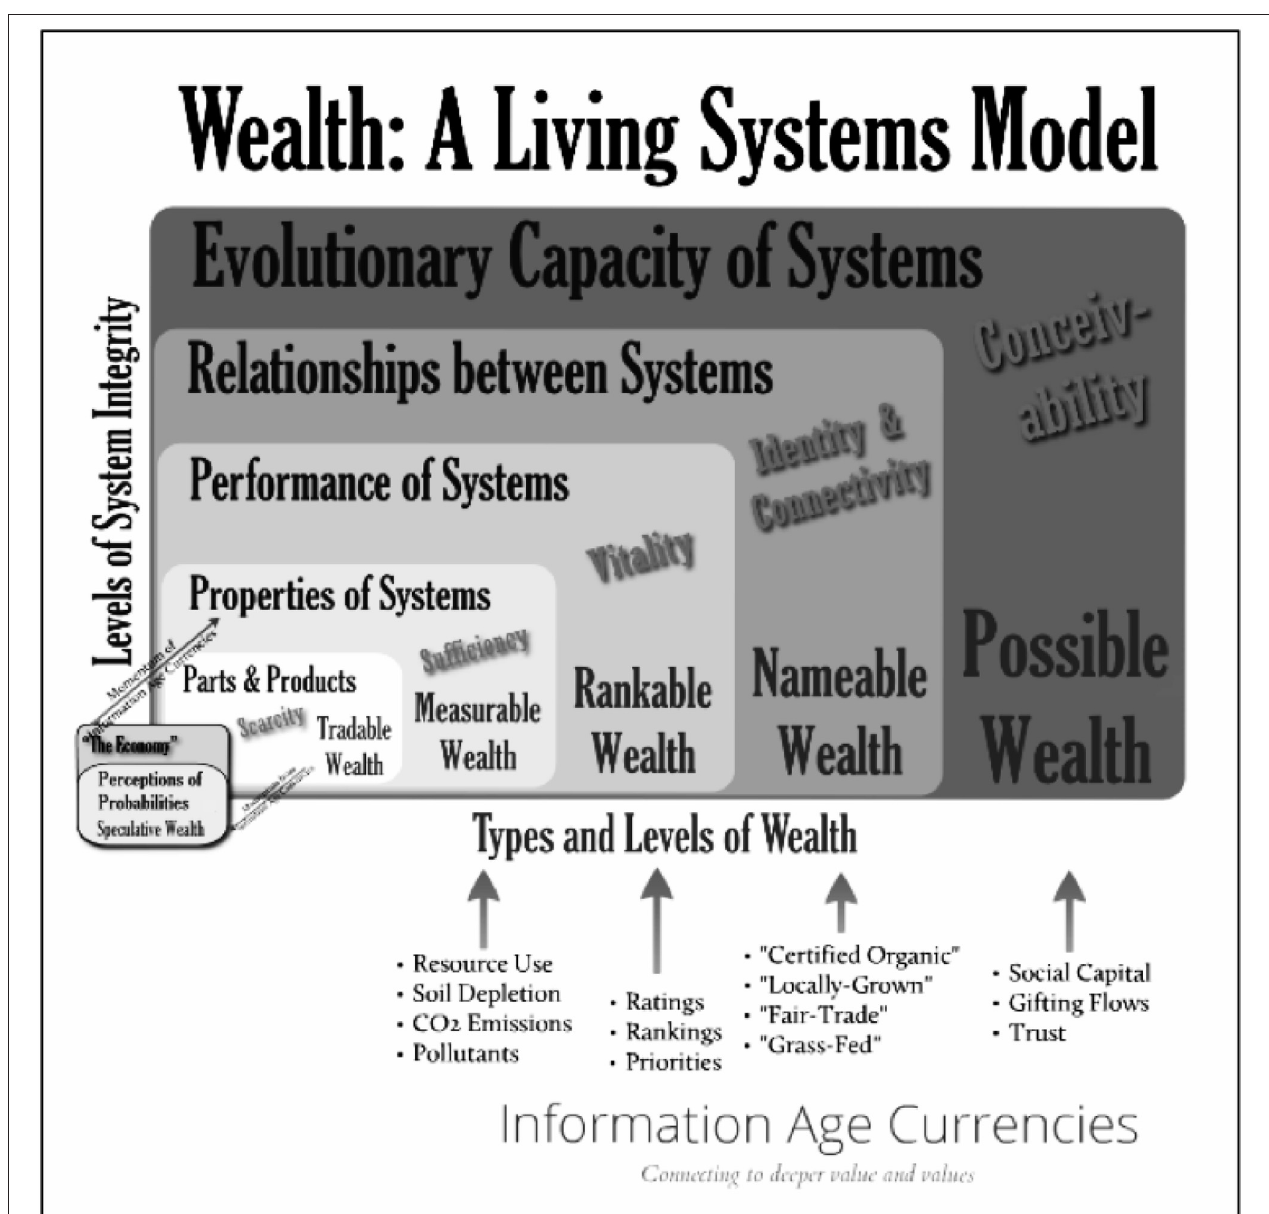
FIGURE 3 | Deep Wealth (used with permission. Graphic by Arthur Brock, published at